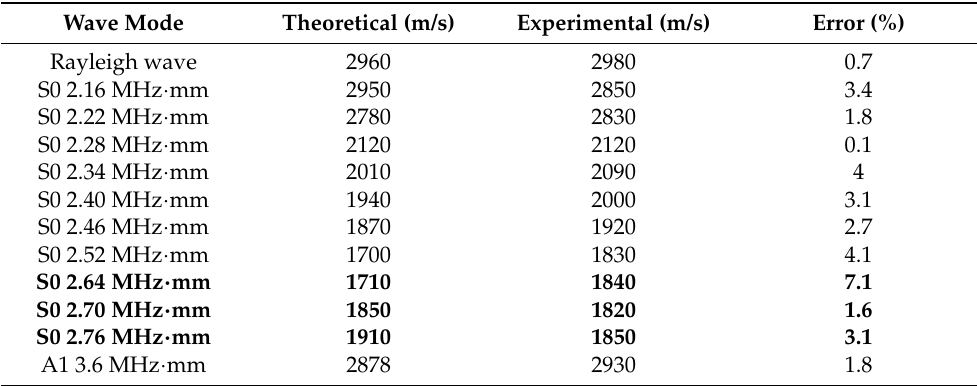
Table 1. Group velocities of Lamb wave